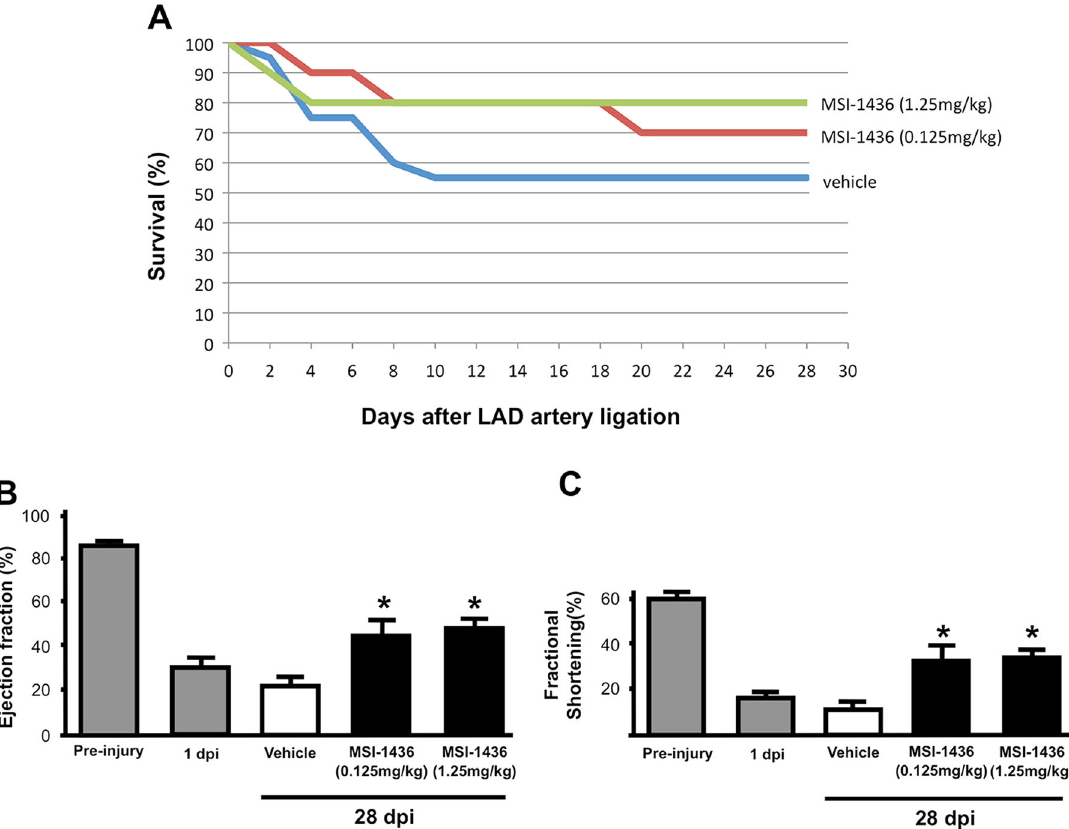
Fig. 3 MSI-1436 improves survival and heart function in adult mice following ischemic injury. a Survival in mice treated with vehicle, 0.125 mg/kg MSI-1436 or 1.25 mg/kg MSI-1436. n = 10 – 20 mice in each treatment group. Ejection fraction b and fractional shortening c as measured by echocardiography. Values are means ± S.E. ( n = 10-18). * P < 0.05 compared to vehicle-treated mice. Mice were administered intraperitoneal (IP) injections of either vehicle, 0.125 mg/kg MSI-1436 or 1.25 mg/kg MSI-1436 beginning 24 h after LAD artery